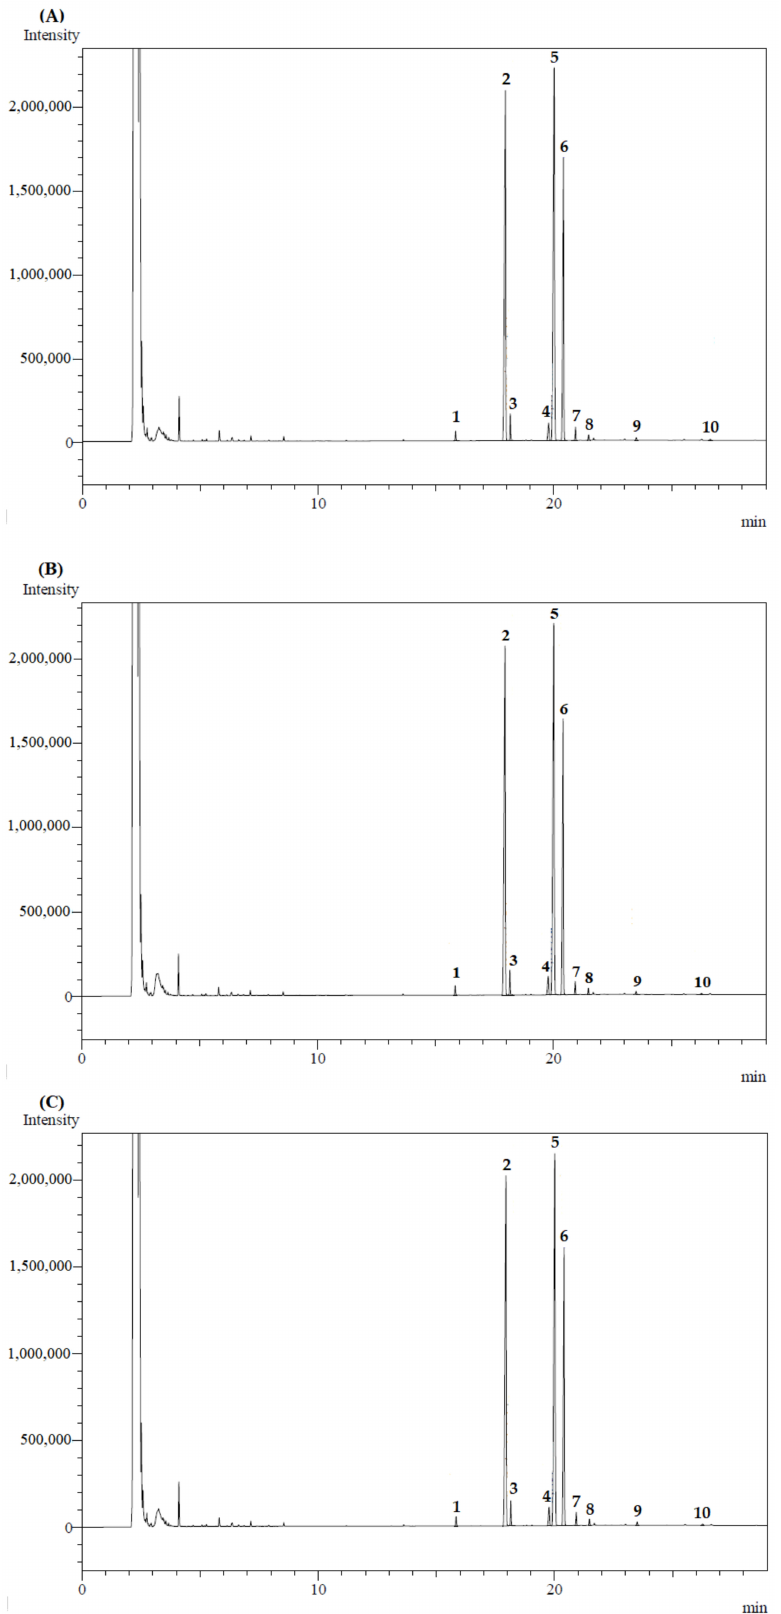
Figure 2. Total ion chromatogram of oils of murici pulp extracts ( B. crassifolia ) obtained by CO 2 -SFE, at 343.15 K and 22 MPa ( A ), 32 MPa ( B ), and 49 MPa ( C ), with the peak numbers corresponding to the compounds identification cited in Table